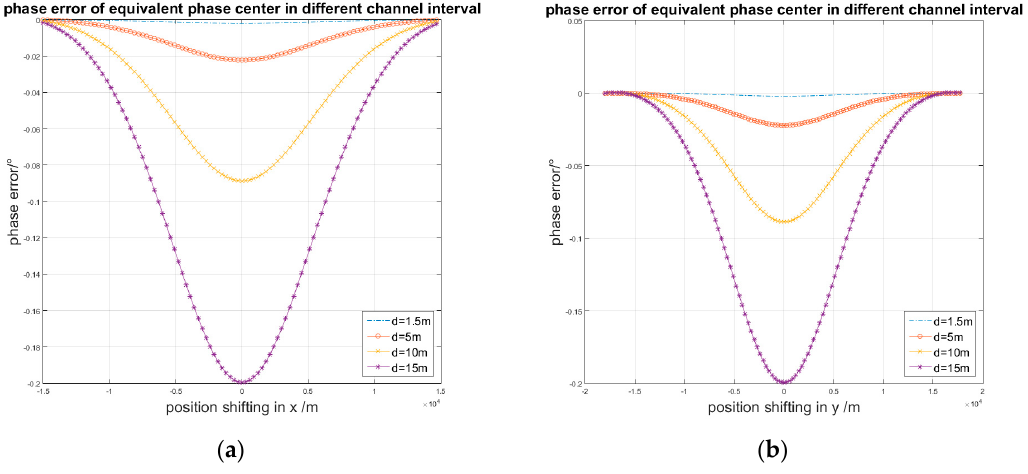
Figure 5. Phase error in different channel interval: ( a ) P2’s position shifting along the x -axis; ( b ) P2’s position shifting along the y -axis.